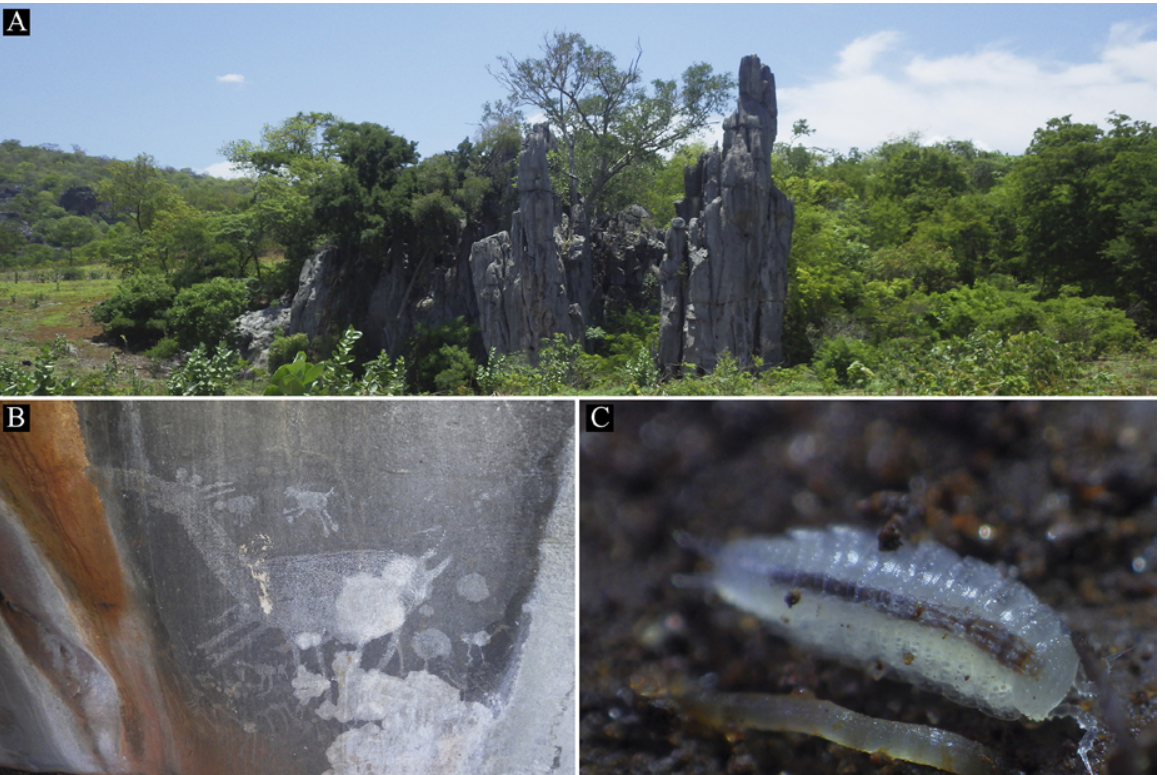
Figure 4. Pectenoniscus montalvaniensis n. sp. A , entrance of Abrigo da Ema cave, outside view; B , ancient rock engravings on the cave wall; C , specimen of Pectenoniscus montalvaniensis n. sp., approximately 2